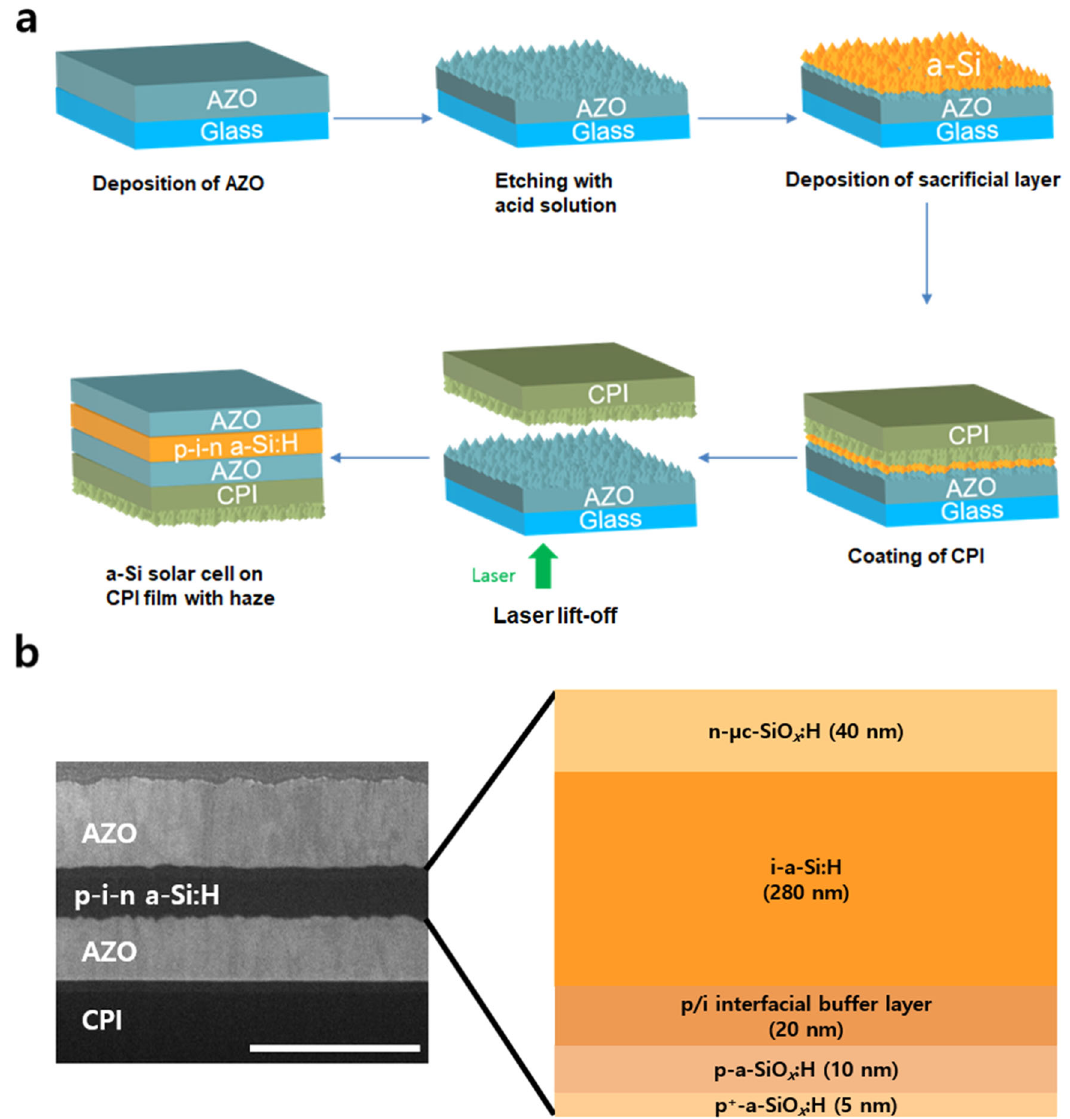
Fig. 1 CPI and solar cells fabrication. a Schematic fabrication of colorless polyimide (CPI) fi lms and fl exible hydrogenated amorphous silicon (a-Si:H) solar cells. b Cross-sectional scanning electron microscopy image and schematic layered structure (thickness) of p-i-n a-Si:H in fabricated solar cells, scale bar is 1 μ